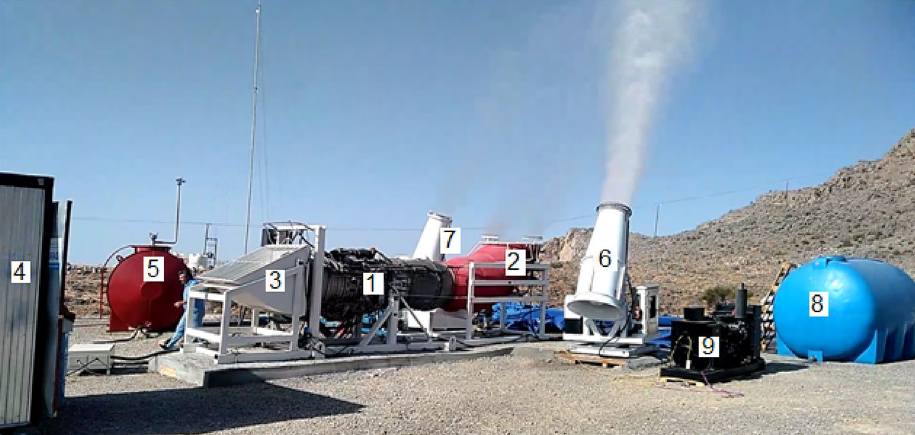
Figure 6. Experimental complex in operation: (1) aircraft engine D-30; (2) nozzle for directing the jet up; (3) engine air receiver; (4) engine start and control cabinet; (5) jet fuel tank; (6) Fog Cannon JY-60; (7) Fog Cannon WP-60; (8) tank for hygroscopic substances solutions; (9) diesel generator 3 × 380 50 kW to feed the Fog Cannon JY-60.